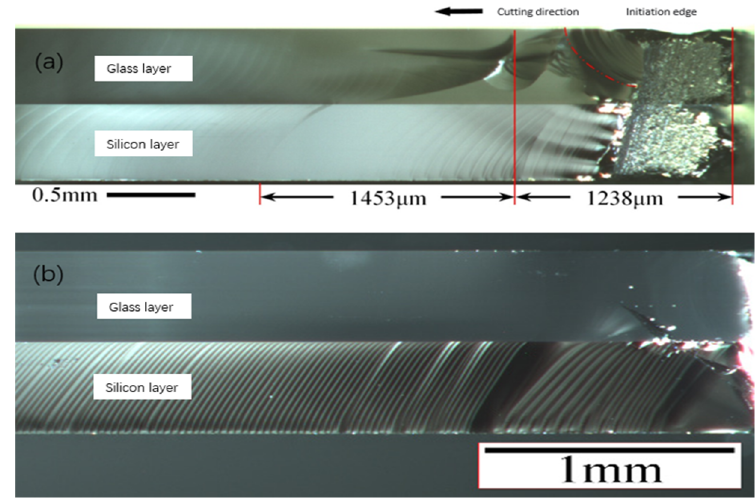
Figure 8. ( a ) High speed entrance profile optical photograph. ( b ) Low speed entrance profile optical photograph [21].